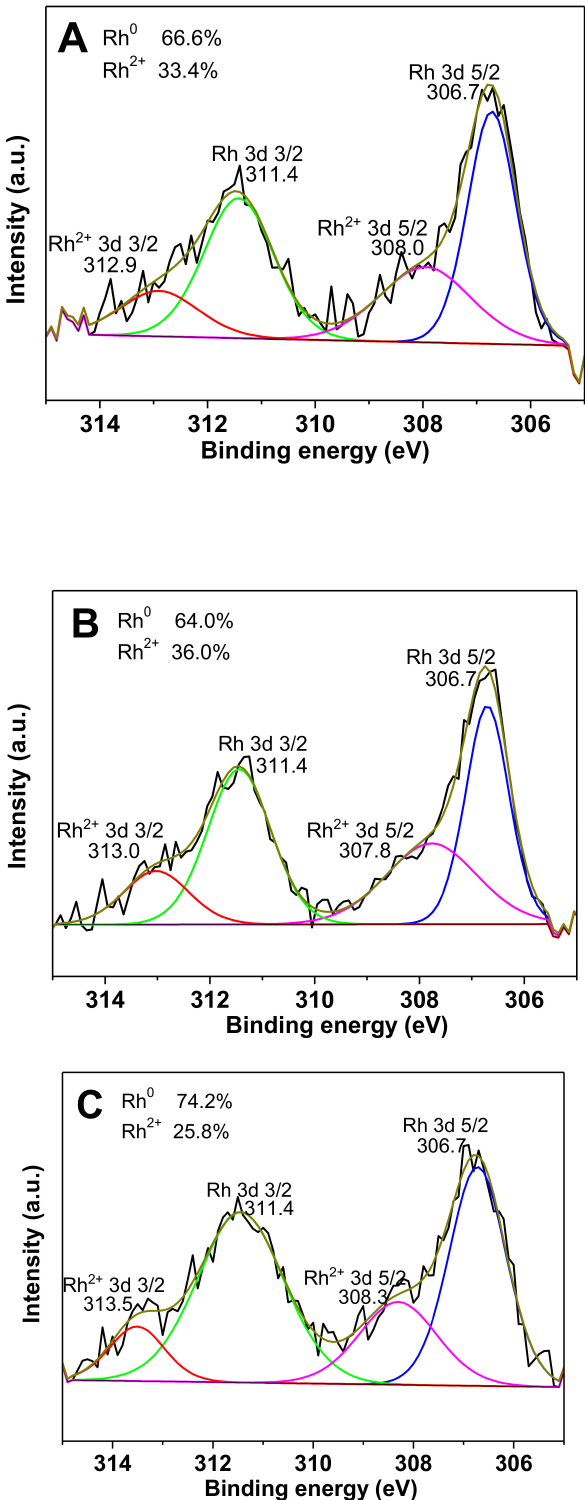
Figure 3. High-resolution XPS spectra of Rh3d in catalysts: Rh0.5/TNTs-P ( A ), Rh0.5/Li-TNTs-P5 ( B ), and Rh0.5/Mg-TNTs-P5 ( C